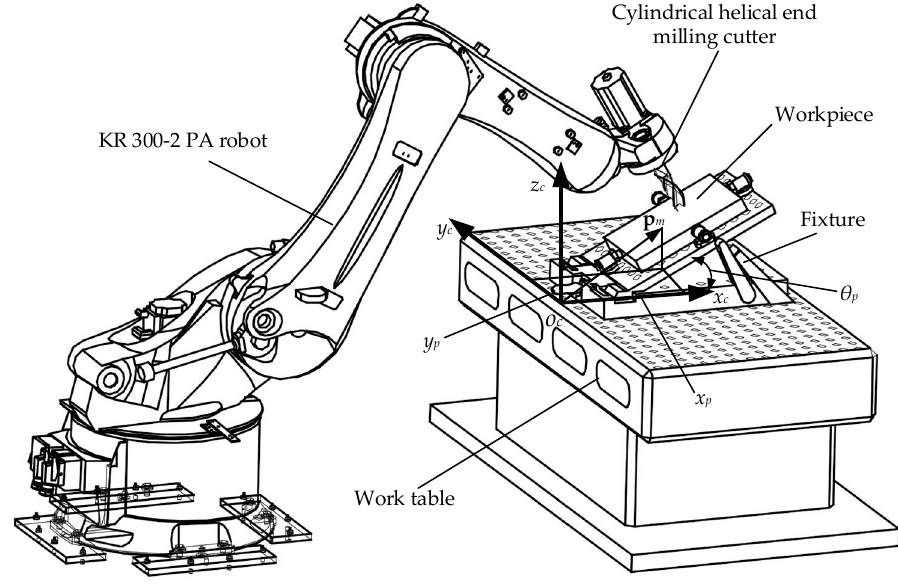
Figure 1. The robotic milling system under study.